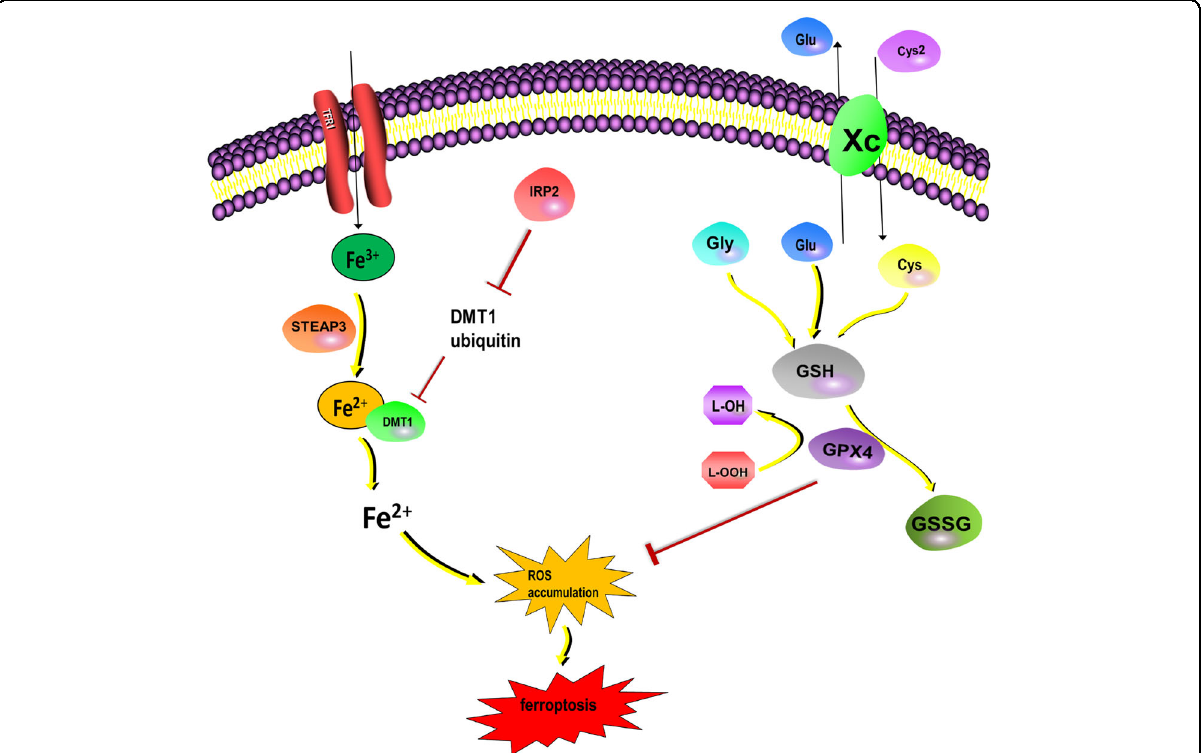
Fig. 4 Cellular ferroptosis. The related lipid peroxidation pathway mediated by GPX4 plays an important role in inhibiting ferroptosis. System Xc — is a cystine/glutamate antiporter that transports intracellular Glu to the outside of the cell and transfers extracellular Cys2 into the cell. Then, Cys2 is converted into Cys for the synthesis of GSH. GPX4 converts GSH into oxidized GSSG and reduces cytotoxic lipid peroxide (L-OOH) to the corresponding alcohol (L-OH), which ultimately reduces ROS accumulation. On the other hand, Fe 3 + enters the cell and is reduced to Fe 2 + by the iron oxidoreductase STEAP3. Then, DMT1 causes Fe 2 + release from the endosome, leading to ROS accumulation, which in turn leads to lipid peroxidation and ferroptosis. IRP2 (IREB2) can inhibit the ubiquitination of TfR1 and divalent metal transporter 1 (DMT1) to increase cellular iron uptake and promote